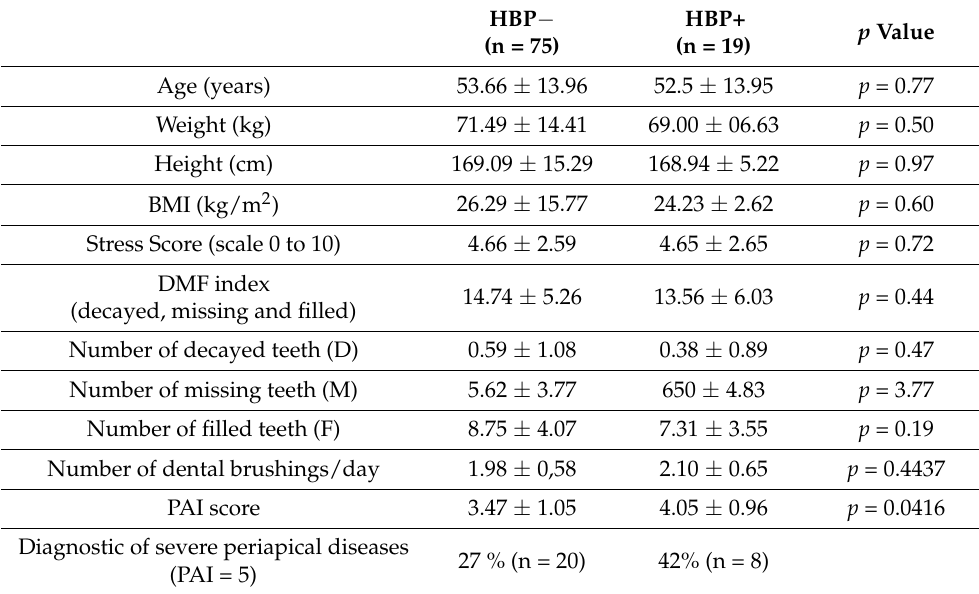
Table 2. Clinical and oral parameters based on the diagnosis of high blood pressure (data as mean ± SD. unpaired Mann–Whitney test). HBP